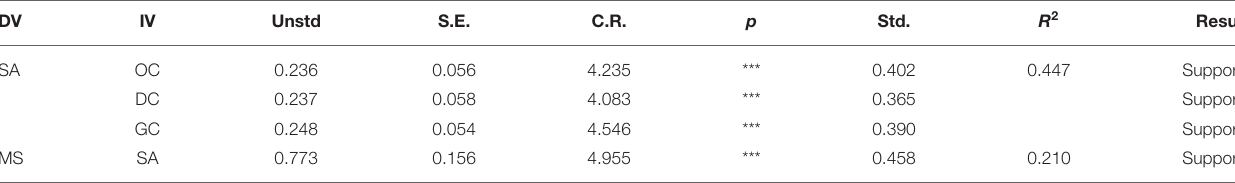
TABLE 4 | Hypothesis testing.